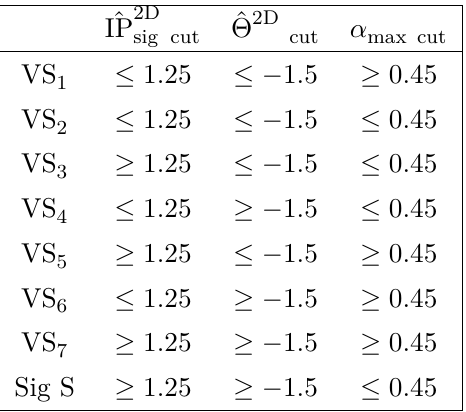
Table 2 . Summary of the track-based displaced-jet tagging requirements to define the seven validation samples, VS through VS , and the signal sample Sig 1 7